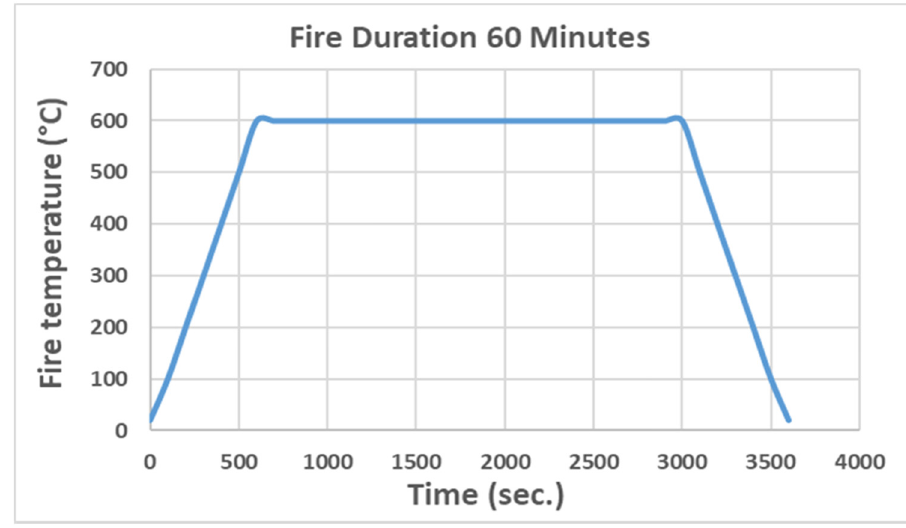
Figure 3: Curve of temperature - time for exposed columns at 600°C and throughout the course of a 1 h fi re [ 18 ]